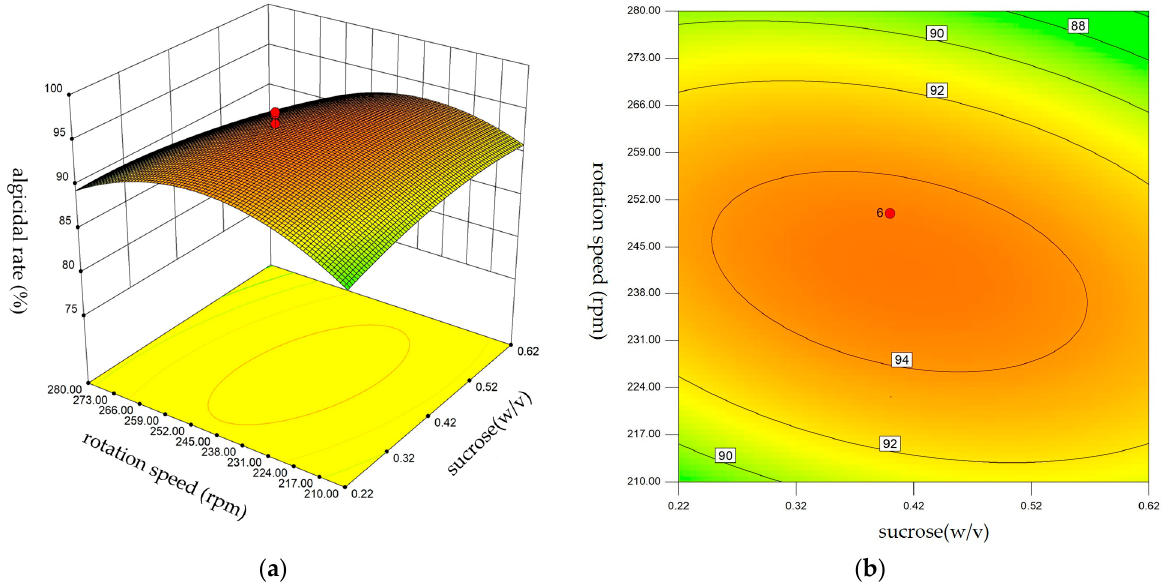
Figure 3. Three-dimensional response surface curve plots ( a ) and the contour plot ( b ) for algicidal rate of rotation speed and sucrose.